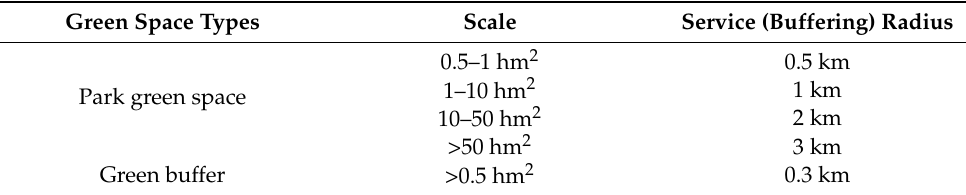
Table 3. Greenland disaster prevention service radius